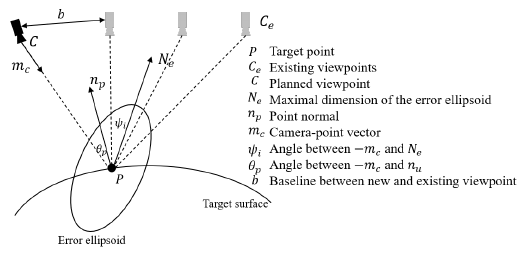
Figure 3. The geometry illustration of viewpoint addition for precision.